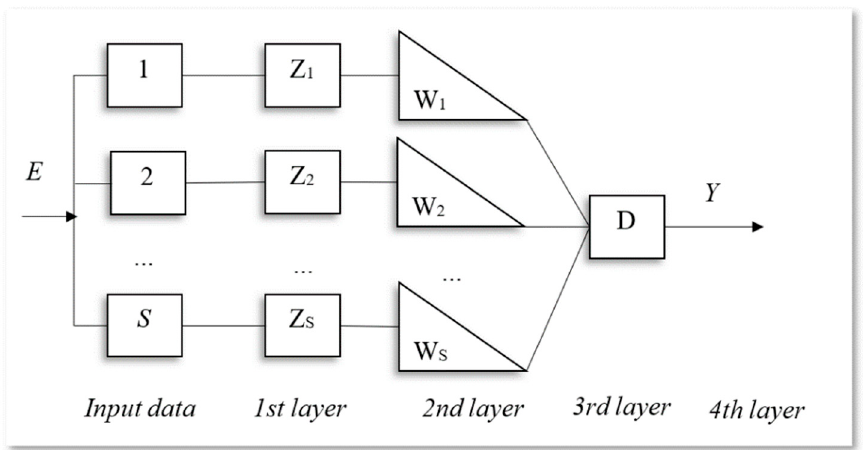
Figure 3. The structure of the neural fuzzy network, where E —a set of specialists; S —number of groups of criteria; Z —neurons; W —functions of postsynaptic potential; D —data defuzzification; Y —output assessment of competencies of specialists.